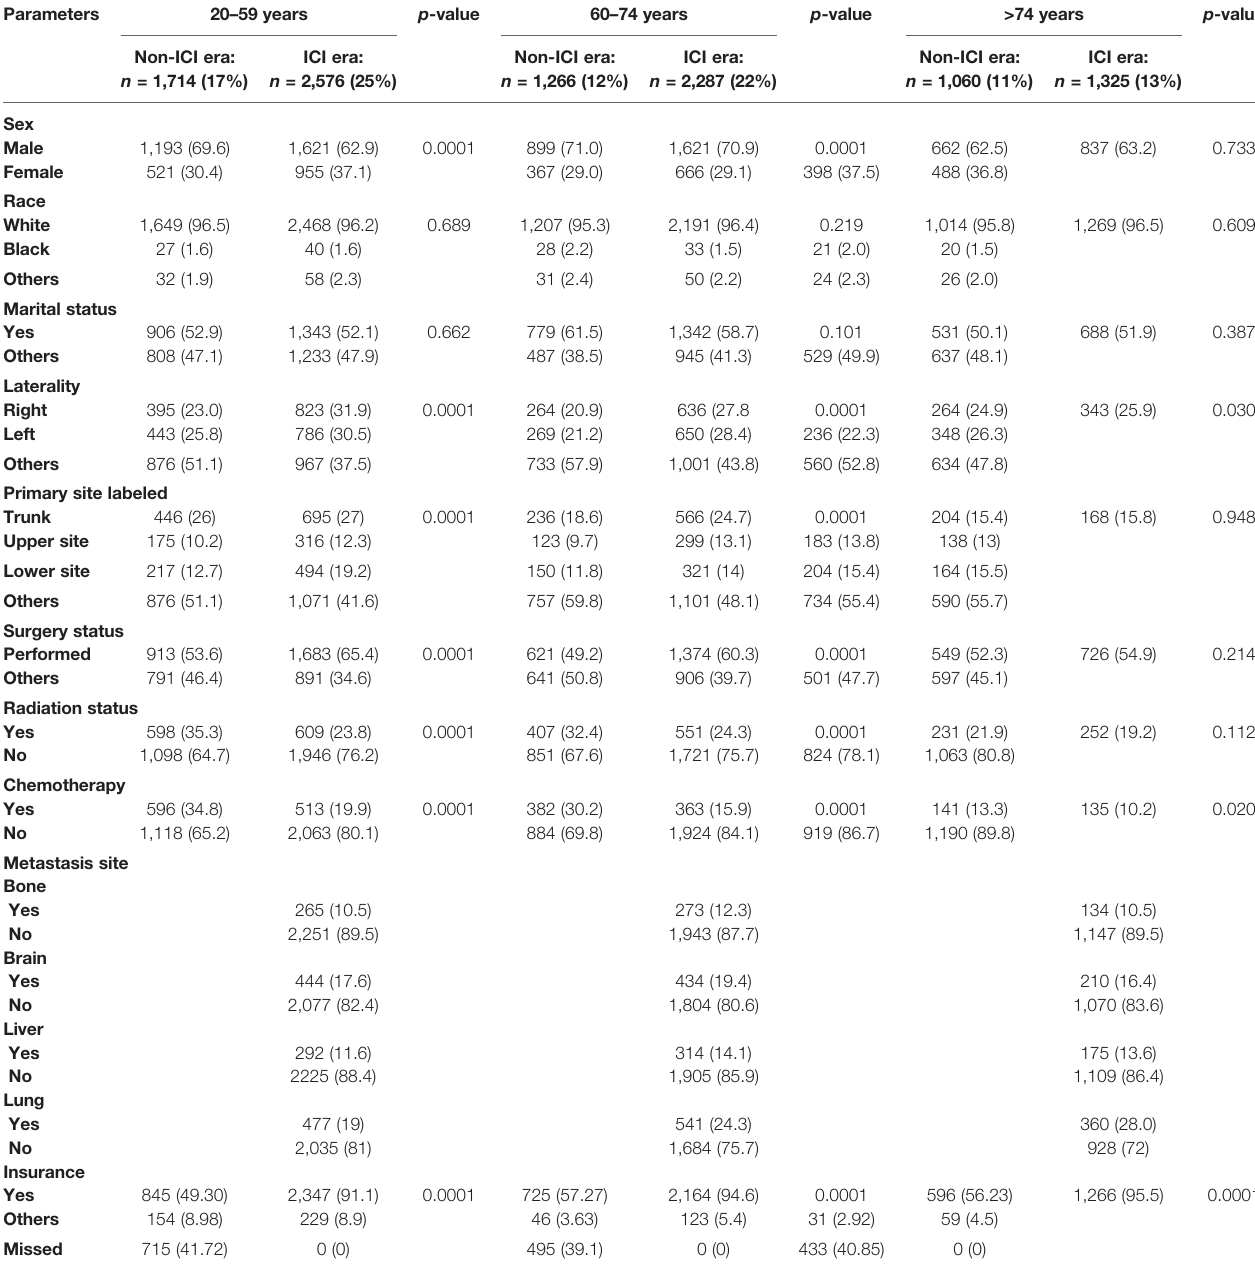
TABLE 1 | Characteristics of advanced melanoma